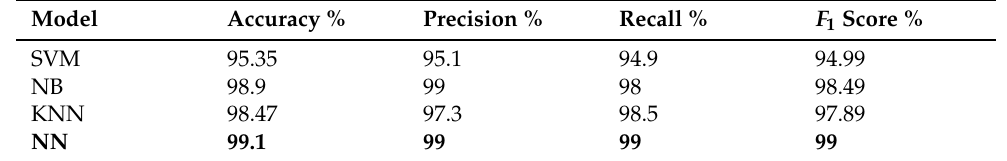
Table 1. Performance Evaluation of the